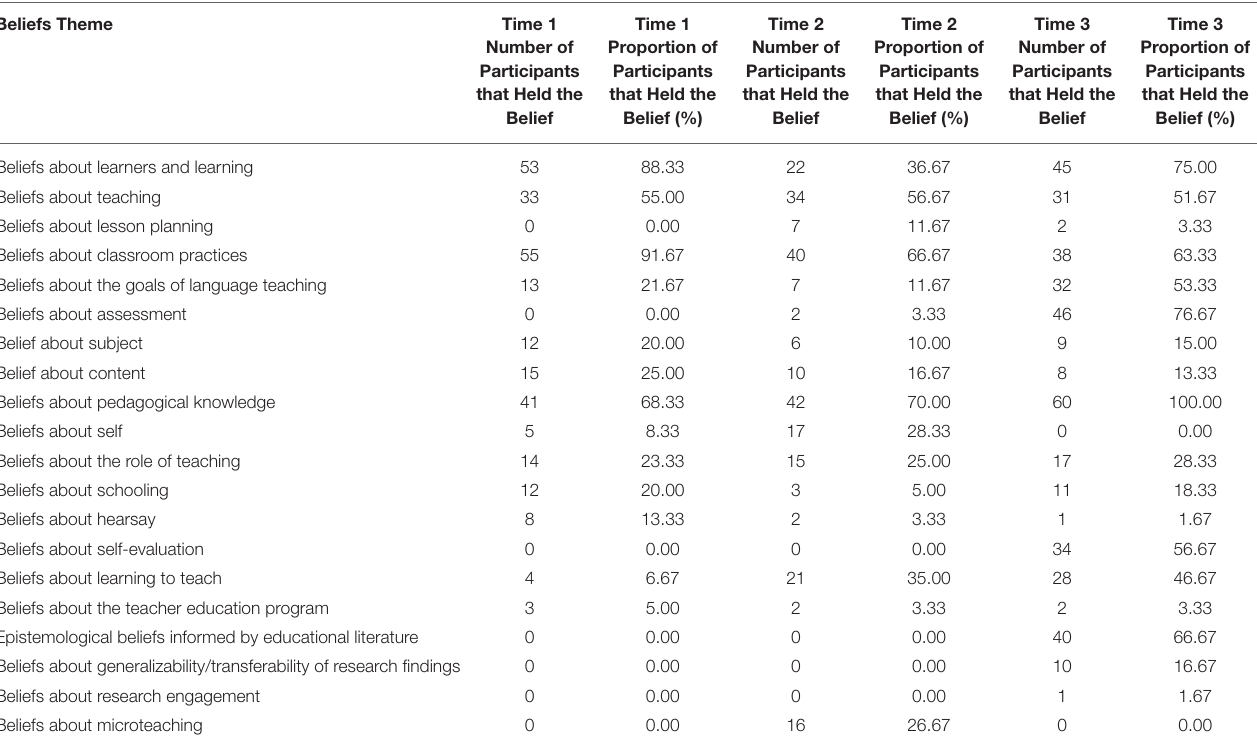
TABLE 1 | Pre-service pre-primary teachers’ beliefs. Beliefs